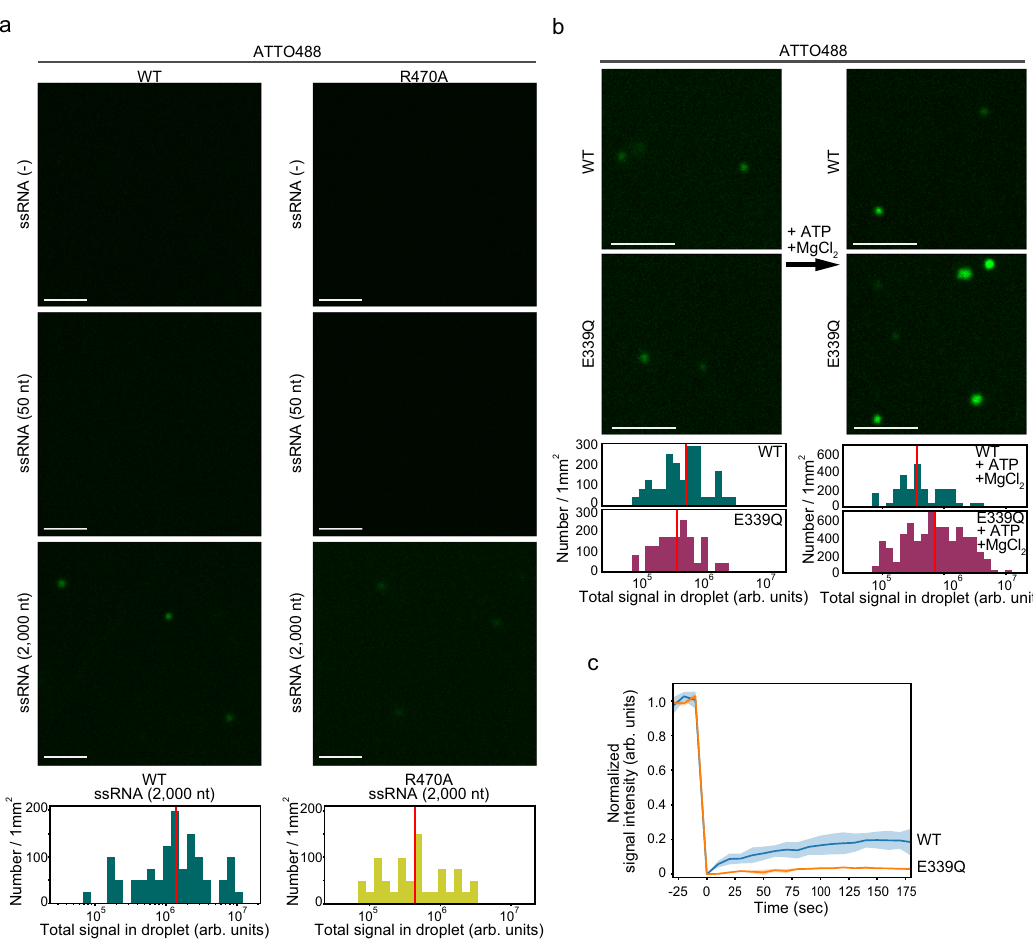
Fig. 3 | The ability of recombinant BmVasa to assemble in vitro droplets is enhancedbyBmVasa – RNAinteraction.a NeitherATTO488-labeledrecombinant BmVasa WT nor R470A assembles the droplets in vitro in the presence of 5% PEG 6000. The addition of 2000 nt-long ssRNAs, but not shorter ones suchas those of 50nt-long ssRNAs, promotesthe droplet assembly ofBmVasaWT invitro. BmVasa R470A mutant only weakly assembled the droplets even in the presence of 2000- nt-long ssRNAs. BmVasa: 1.5 μ M. Scale bar: 5 μ m. Histograms of total ATTO488 signal intensity of a droplet in the presence of 2000 nt-long ssRNAs are shown. Red line indicates the median [ p =1.56×10 − 4 (WT vs. R470A), by